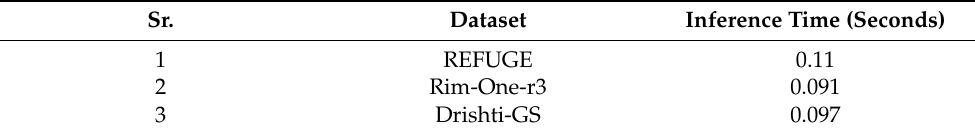
Table 5. Inference time (per image) computation using